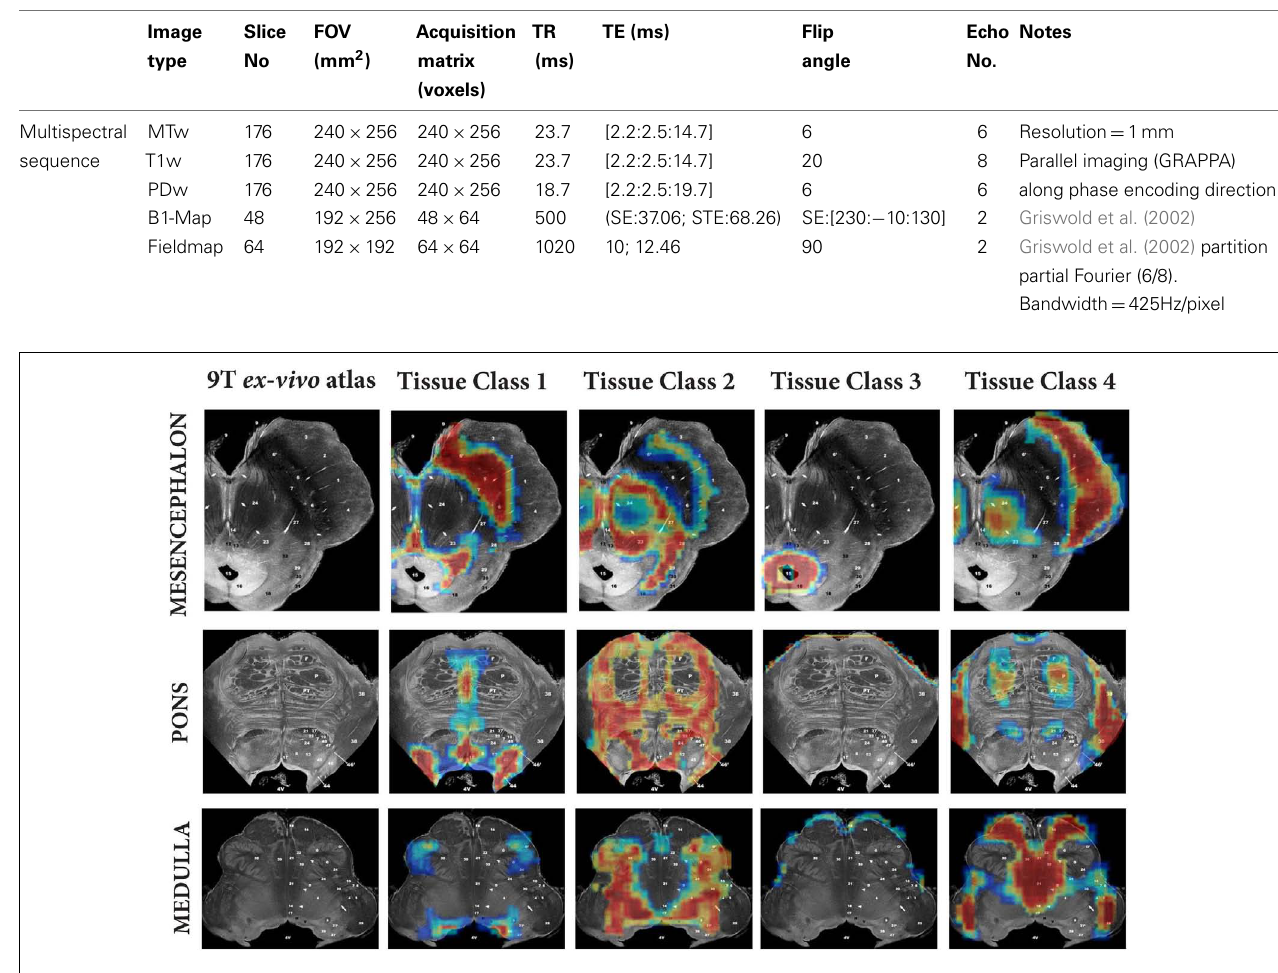
FIGURE 1 | Comparison of brainstem tissue classes against three corresponding ex vivo brainstem sections from “MR microscopy at 9.4T”(taken from Duvernoy’sAtlas of the Human Brain Stem and Cerebellum with permission) . Figure reproduced from Lambert et al. (2013) with permission from Elsevier.